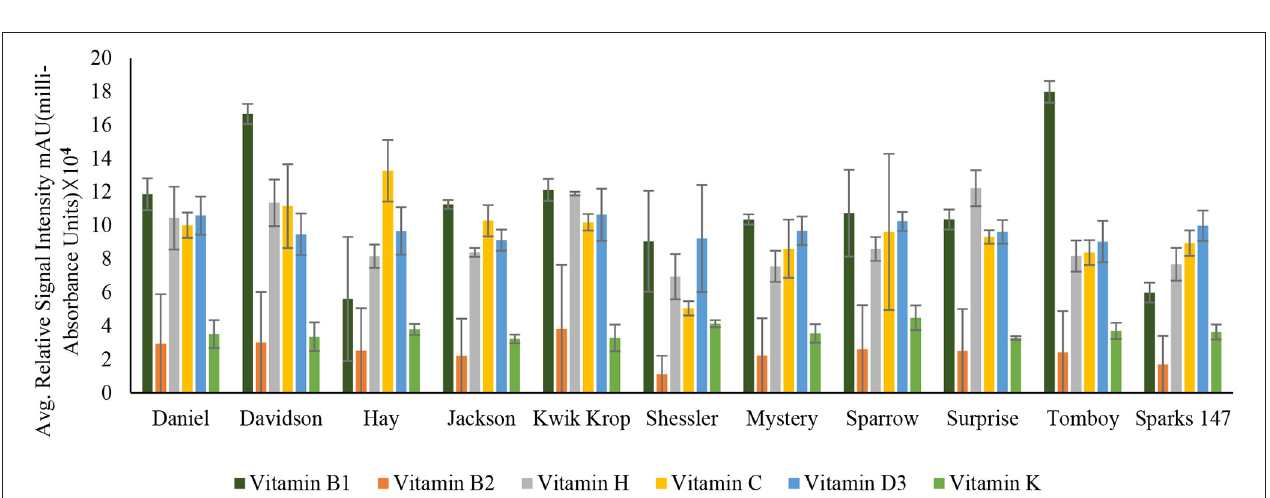
FIGURE 3 | Concentration of Vitamin B 1 (Thiamin), Vitamin B 2 (Riboflavin), Vitamin H (Biotin), Vitamin C (Ascorbic acid), Vitamin D 3 (Cholecalciferol) and Vitamin K (Phylloquinone) in 11 black walnut cultivars.